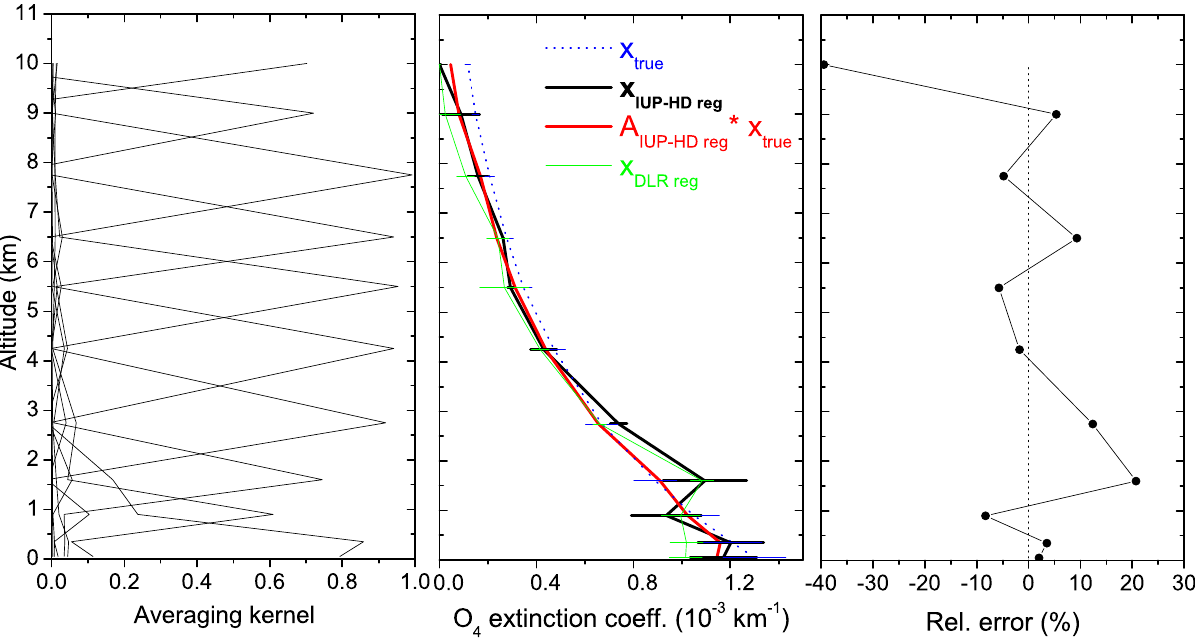
Fig. 7. Retrieval of the vertical distribution of the O 4 extinction coefficient ( E O ). Left: Averaging kernels showing ∼ 8 degrees of freedom. 4 Center: The E O true state is shown in blue (considering 10% error). X IUP-HD reg (in black) is the regularized E O profile if the IUP-HD 4 4 E M profile (see Fig. 5) is included in the RT model (the error bars include the retrieval noise and the effect of uncertainties of the ground albedo and the aerosol load). The contribution of the true state to the row space (IUP-HD reg) is shown in red. For comparison purposes, X DLR reg (in green) corresponds to the regularized E O profile if DLR E M (b) profile (in dark blue in Fig. 5) is included in the RT model. 4 Right: Relative error of the (IUP-HD) E O